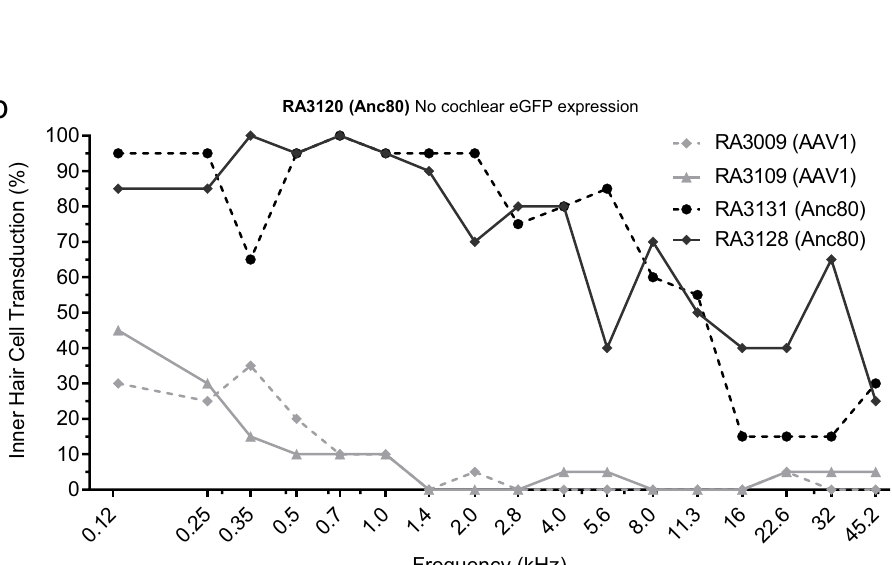
and spinal cord for both serotypes were considered negative since levels were around background level. Higher vector DNA copies were detected in CSF and liver in animals injected with AAV1 compared with Anc80L65 monkeys, with the exception of animal RA3120, which was injected with Anc80L65 but did not express eGFP in the cochlea.